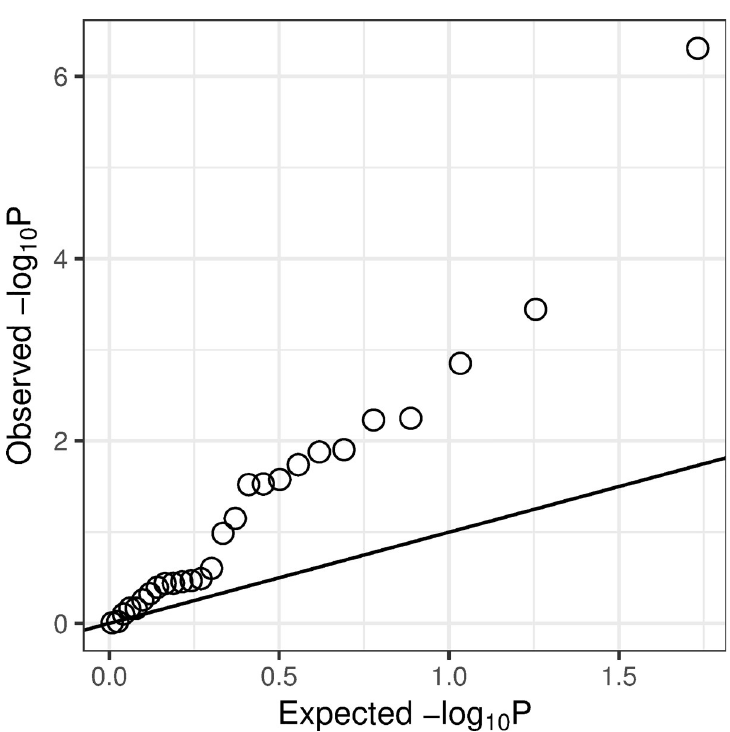
https://doi.org/10.1371/journal.pone.0215026.g001